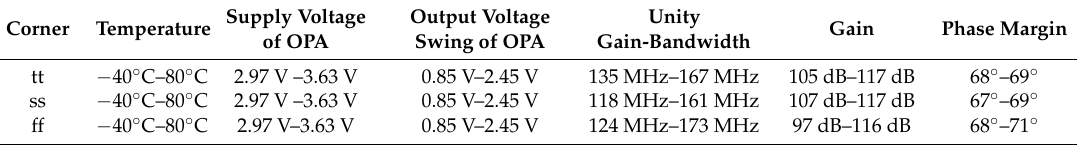
Table 1. Simulation results of the OPA.